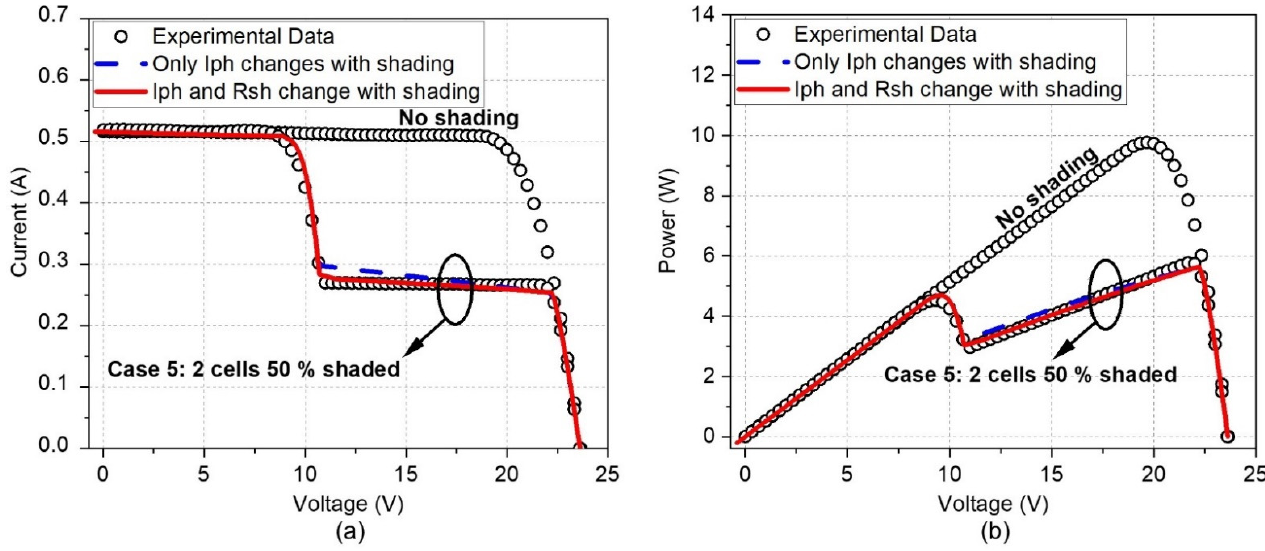
Figure 10. Experimental and calculated I-V and P-V curves of the 10 W PV module for cases 1 to 4. The black circles are the experimental results. The red solid lines represent the calculated results that consider the variation of both I ph and R sh . The blue dashed lines represent the calculated re- sults that consider the variation of I ph only: ( a ) I-V curves; ( b ) P-V curves. Each experimental curve is the average of three measurements under a light irradiance of 1000 W/m² measured at the centre of the module at a module temperature of 25 °C. Figure 11a,b show the I-V and P-V curves for case 5 where the shading is imposed on two solar cells. Figure 11c,d show the I-V and P-V curves for case 6 where four solar cells in the same string were shaded. It can be seen that the deviation between the calculated and experimental results decreases when the number of the shaded cells is increased. The difference among the three sets of data becomes negligible when the number of the shaded cells is increased to four. This indicates that the deviation caused by neglecting the varia- tion of R is only significant for the cases where the shading occurs on one cell. When s h the shading occurs on more than one cell, such deviation becomes negligible. This can be attributed to the fact that the breakdown voltage shifts to higher negative values when more cells are reverse biased, resulting in a flatter I–V curve in this region [7].